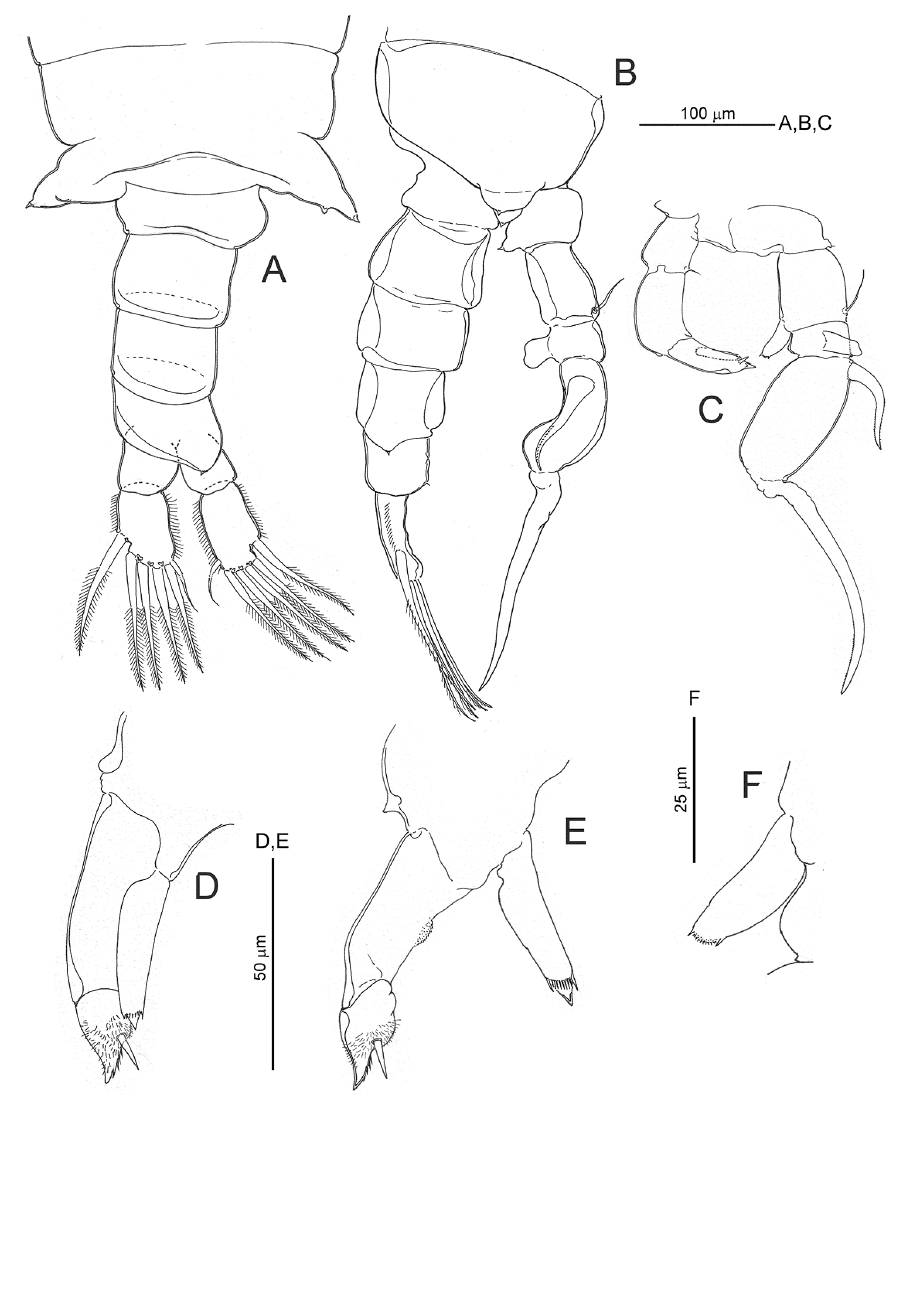
Figure 5. Notodiaptomus cannarensis sp. n., adult male. A last pedigerous somite plus urosome and cau- dal rami, dorsal B inset of last pedigerous somite with fifth legs attached plus urosome and caudal rami, right lateral aspect C fifth legs, posterior D and E different aspects of left fifth leg rami F inset of right fifth leg